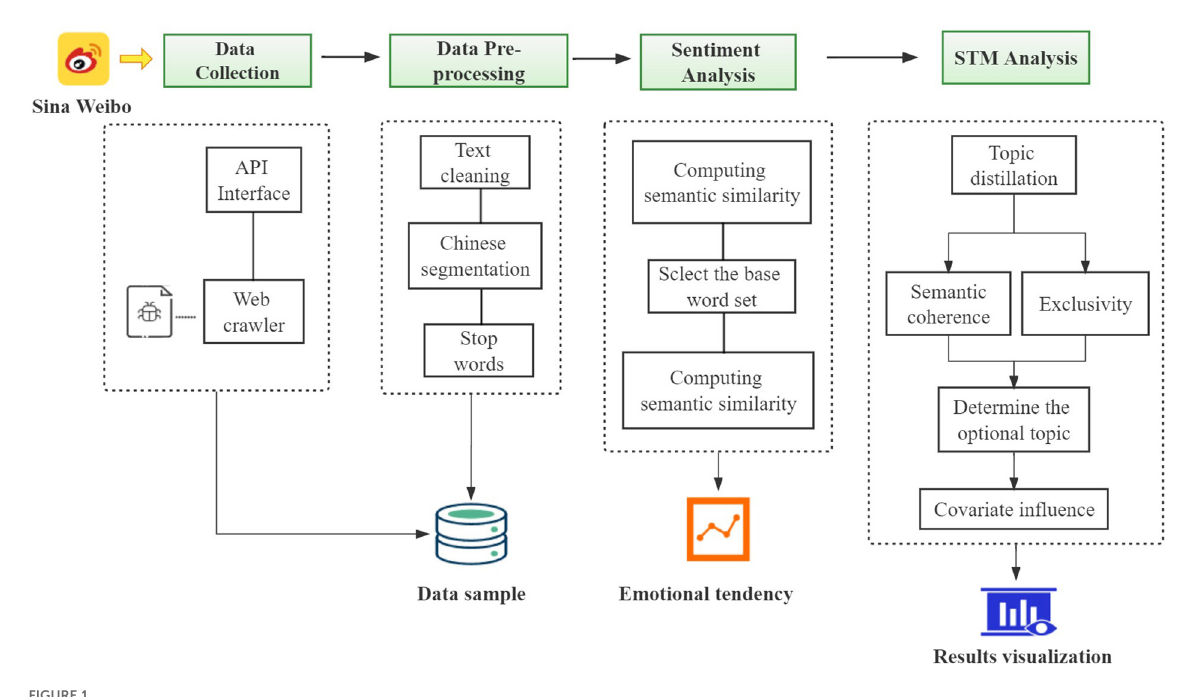
FIGURE1 The framework of this